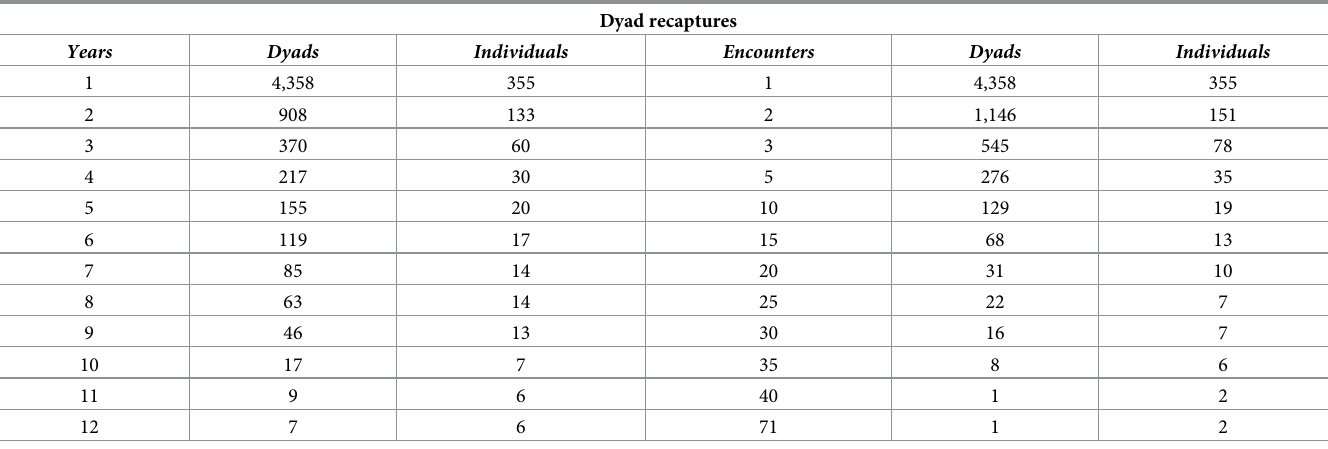
Table 3. Dyad recapture statistics for pairs of associated humpback whales in our study.